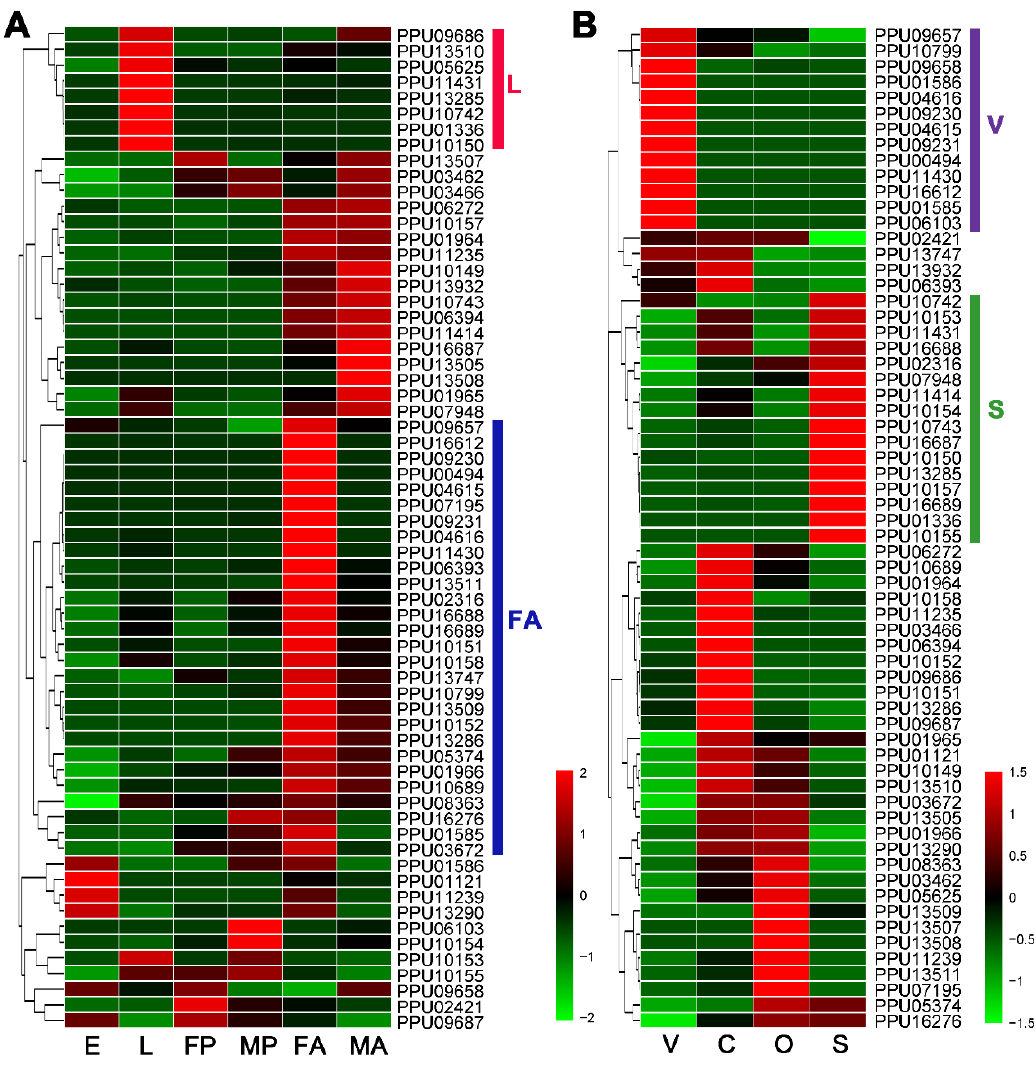
Figure 1. Heatmap analysis of P. puparum lipase genes across different developmental stages ( A ) and tissues ( B ). Log 2 FPKM values are indicted by a green–red bar where the red represents higher expression levels, the green represents the lower. Lipases are sorted into different groups according to their expression profiles. Colored bars at right represent the group names. E = eggs, L = larvae, FP = female pupae, MP = male pupae, FA = female adults, MA = male adults, V = female venom glands, C = carcass (female adults without venom glands), O = ovaries, S = larval salivary glands. A number of predicted lipase genes of P. puparum were selected for qPCR analysis, and the